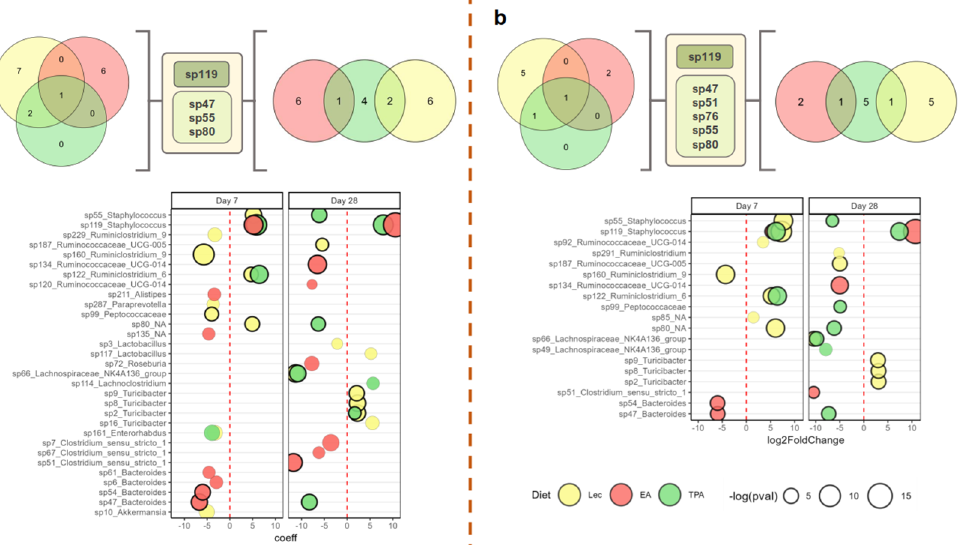
Figure 4. Differential abundance (DA) analysis of differences in amplicon sequence variant (ASV)- level microbial abundance between supplement groups and water across sampling timepoints. Significant differentially expressed taxa for models constructed using LinDA ( a ) and limma/voom ( b ). Venn diagrams (top) show mutually significant taxa between timepoints (day 7, left and day 28, right) and diets. Bubble blots (bottom) display change coefficients/log-fold change of differentially abundant taxa. Bubble size represents the negative logarithm of p -values for each taxon. Bolded bubbles represent taxa that were found to be mutually significant between models.